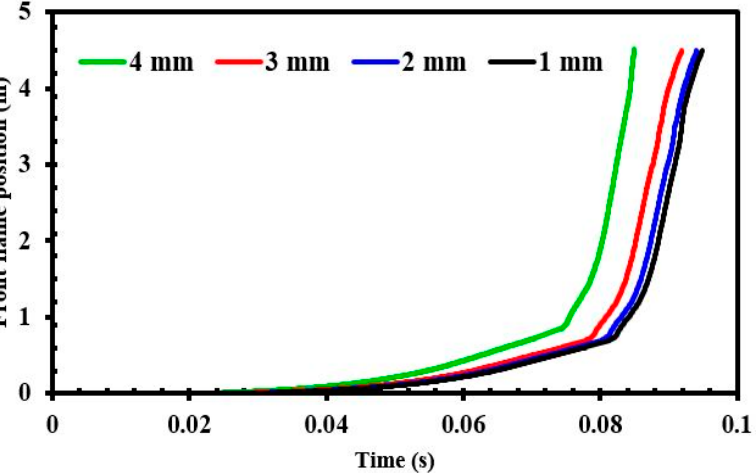
Figure 3. Mesh sensitivity analysis of H 2 –air mixture with a 13% hydrogen concentration for different computational grids .